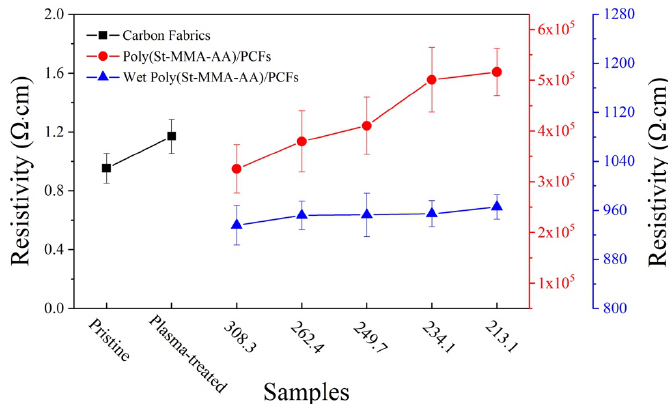
Figure 7. Electrical resistivity of pristine, plasma-treated carbon fabrics, Poly(St-MMA-AA) / PCFs and wet Poly(St-MMA-AA) / PCFs with various diameters of 308.3, 262.4, 249.7, 234.1 and 213.1 nm.